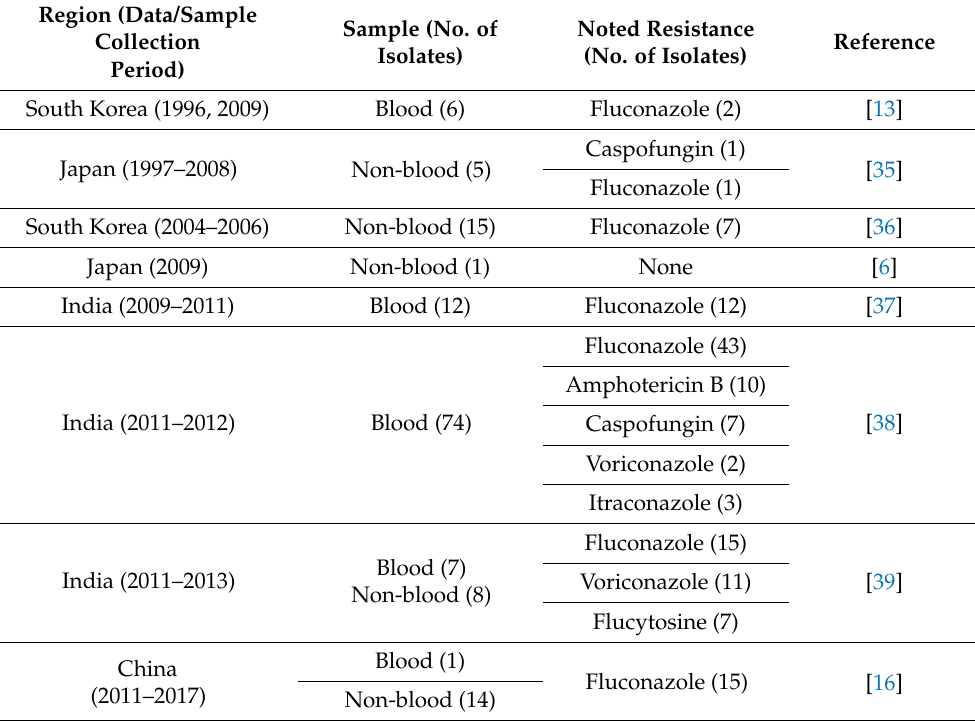
Table 1. Chronological order of the incidences of C. auris infection in healthcare facilities in Asia